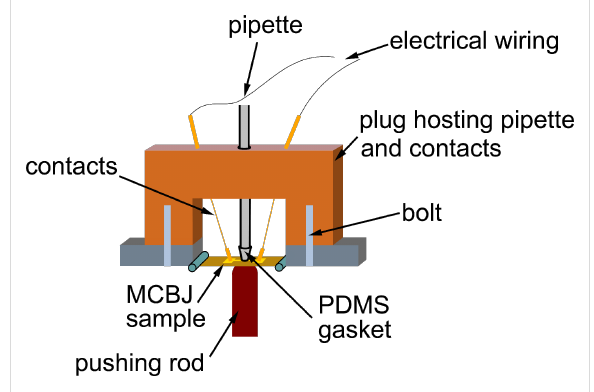
Figure 8: Break junction set-up for use in liquid environment. A PDMS- sealed glass pipette, in which the molecular solution circulates, is pressed onto the central part of MCBJ chip with the help of a plug screwed to the sample holder. The electrical contacts are realized in this case via spring-borne contacts outside the gasket. In some experi- ments the contact between the contact tips and the sample was medi- ated by small indium